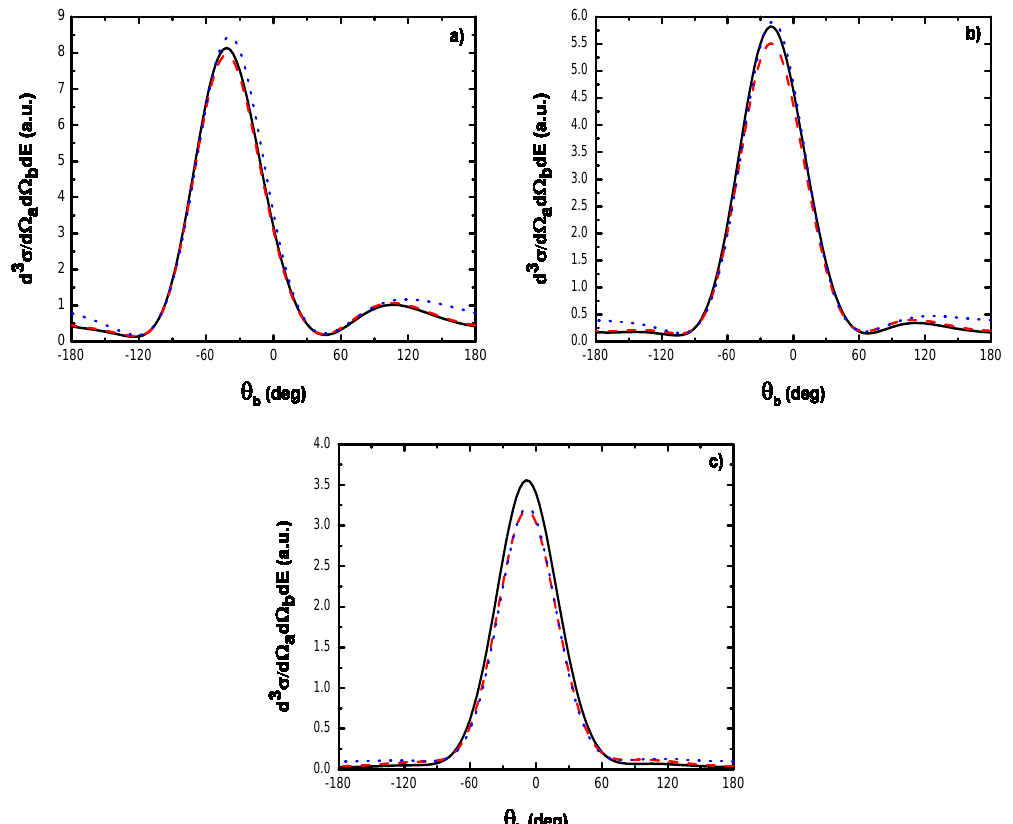
Figure 4. Triple differential cross sections corresponding to the laser-assisted electron-impact ionization process of atomic hydrogen as a function of the ejected angle θ b , for no net exchange of photons ( (cid:96) = 0 ) at different impact energies. The incident electron energy is ( a ) E = 100 eV, ( b ) E = 50 eV, k i k i = 30 eV. The ejected electron energy is est E = 5 eV, and the scattering angle is θ a = 5 ◦ . et ( c ) E k k b i The laser frequency is ω = 1.17 eV and the electric field strength is est E 0 = 1 × 10 7 V/cm. The laser polarization vector of the field is set parallel to the wave vector of the incident electron ( ˆ ε // k i ) . : second Born approximation results. − − − : first Born approximation results. · · · · · : results obtained by ignoring the dressing of the